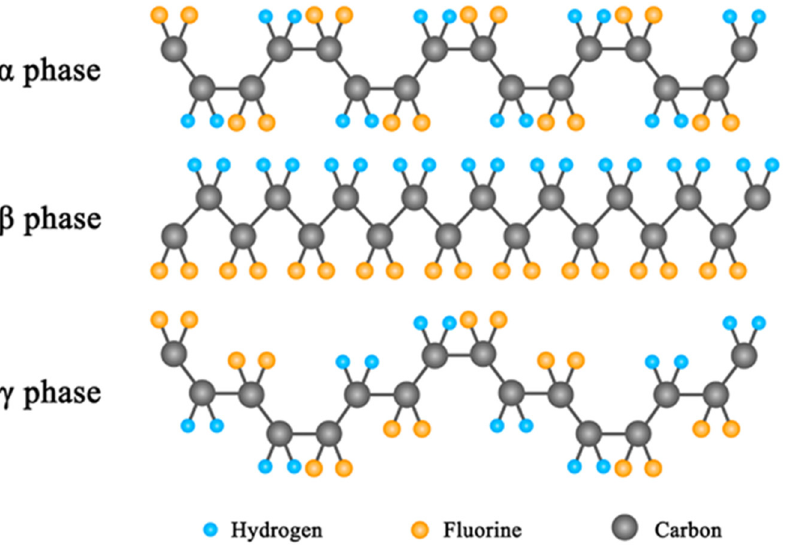
Figure 1. The semi-crystalline α , β , and γ conformations of poly(vinylidene fluoride) (PVDF) [28]. Reproduced with the permission from reference [28].